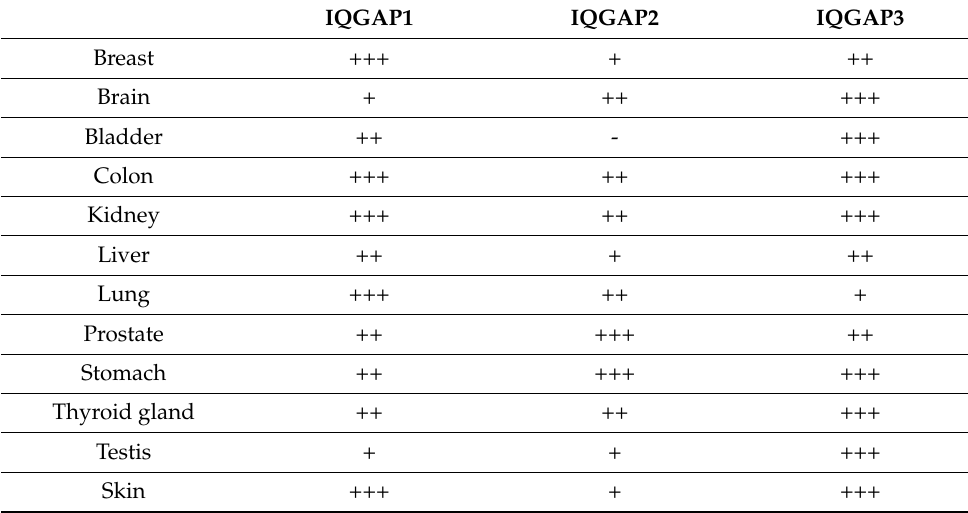
Table 1. The protein expression of IQGAPs in organs (data adapted from the Human Protein